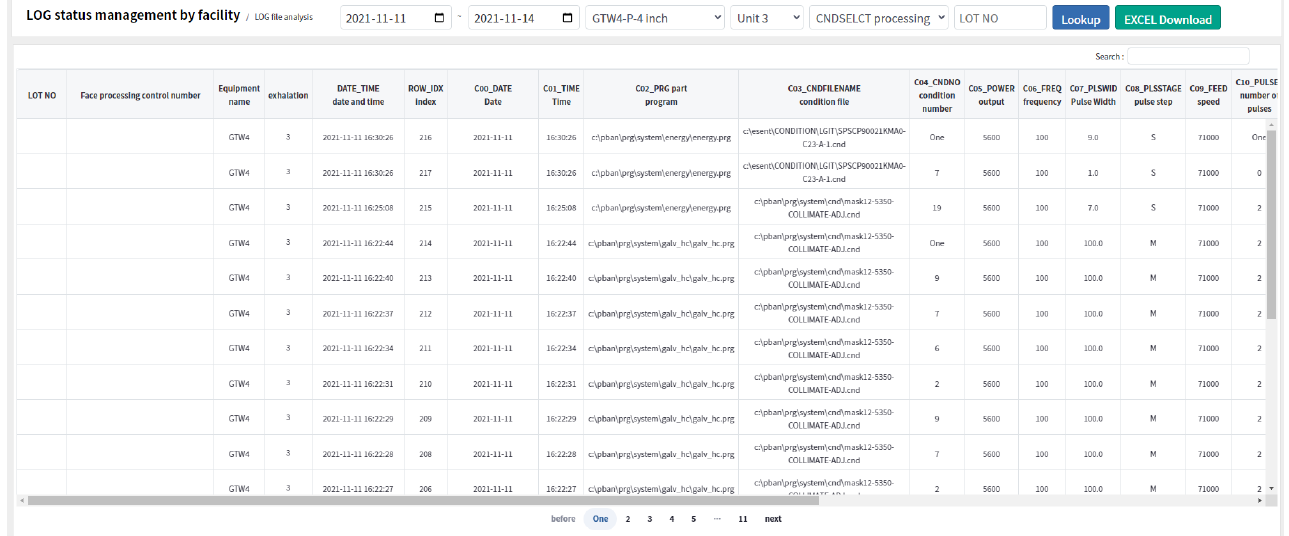
Figure 22. The log file status for each facility.